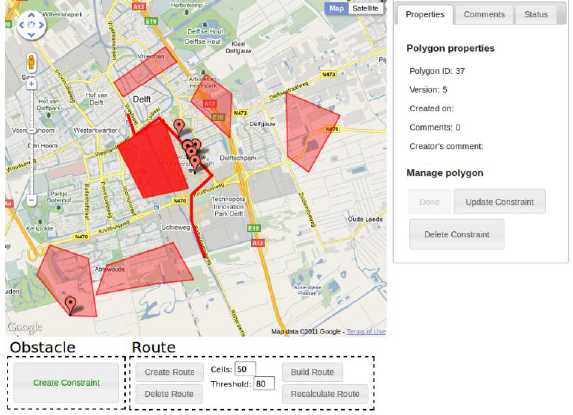
Figure 1. The desktop interface. Polygons denote real-world obstacles.